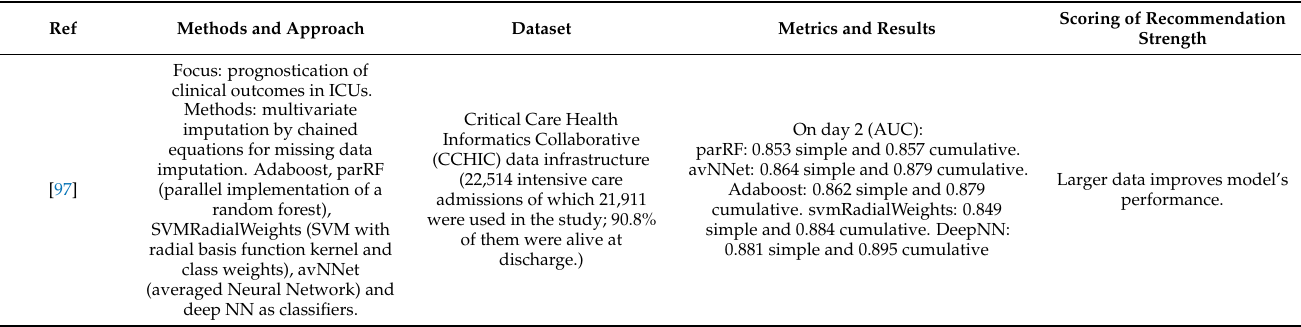
Table 4. Results and